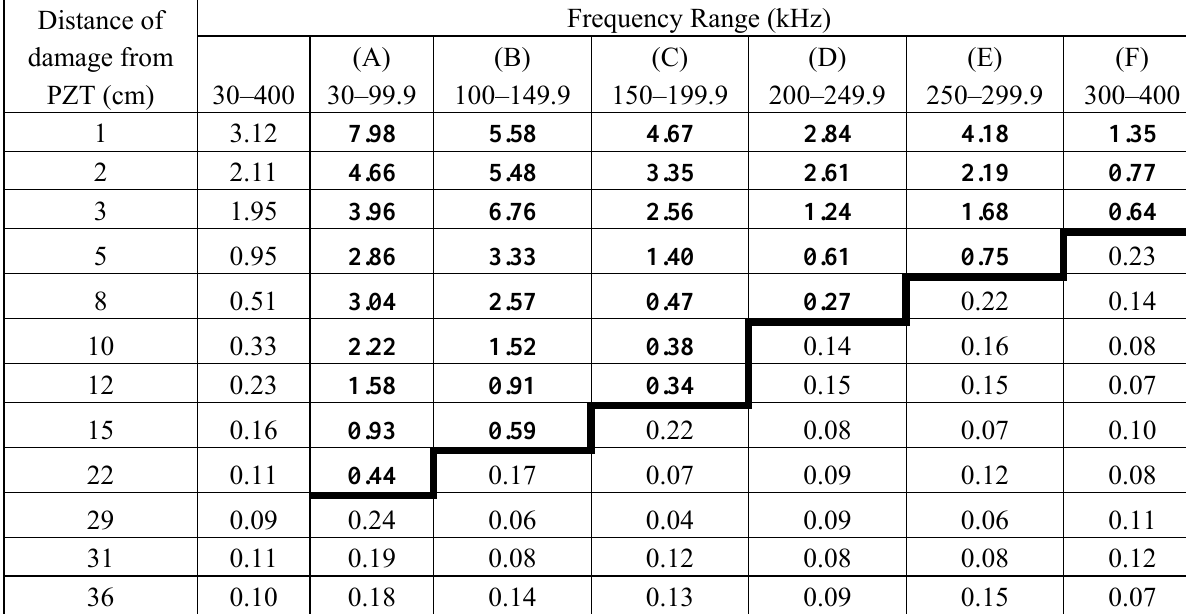
Table 4. RMSD-S versus distance for three PZTs.